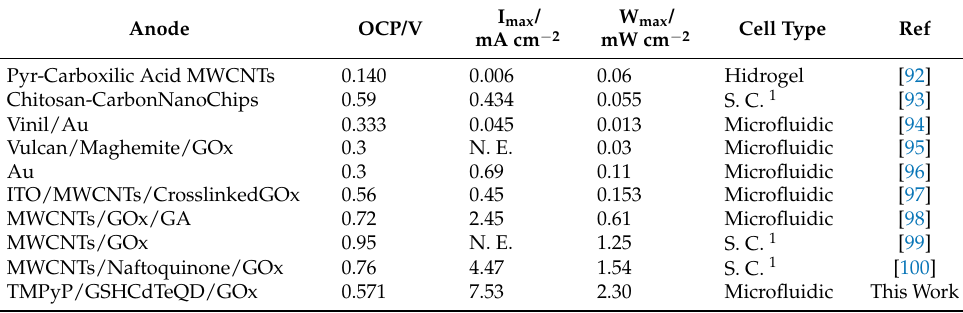
Table 3. Performance comparison between different enzymatic fuel cells. Anode OCP/V